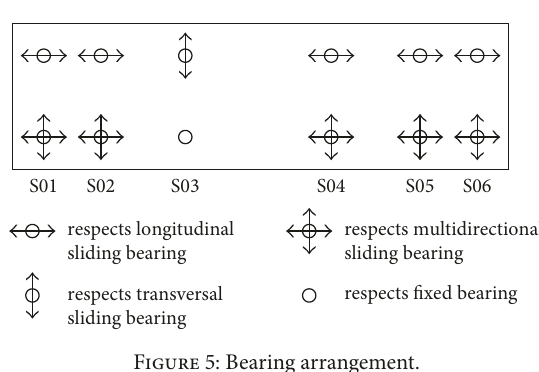
Figure 5: Bearing arrangement.